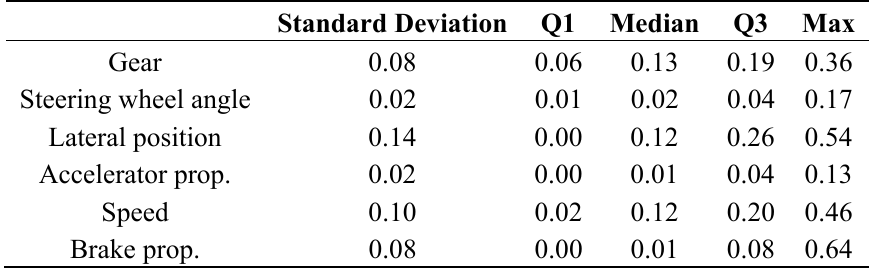
Table 9. Relevant characteristics for Expert 2.